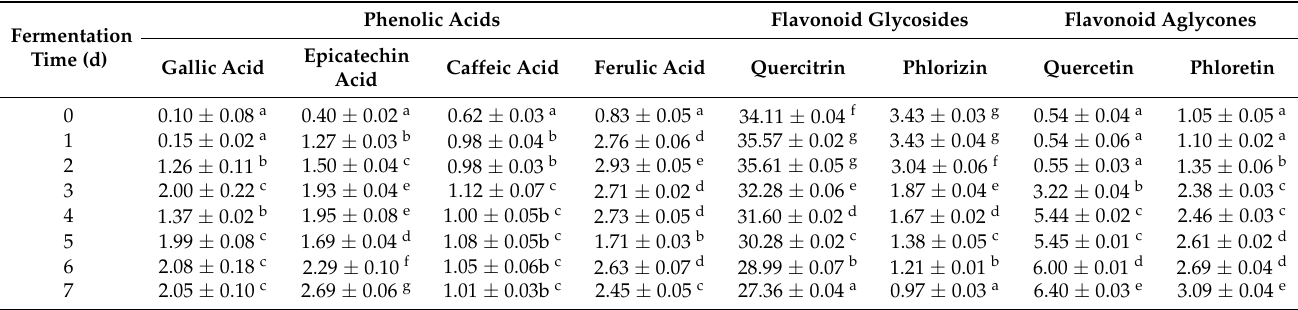
Table 1. Phenolic profiles in apple pomace during fermentation ( µ g/mL). Phenolic Acids Flavonoid Glycosides Flavonoid Aglycones